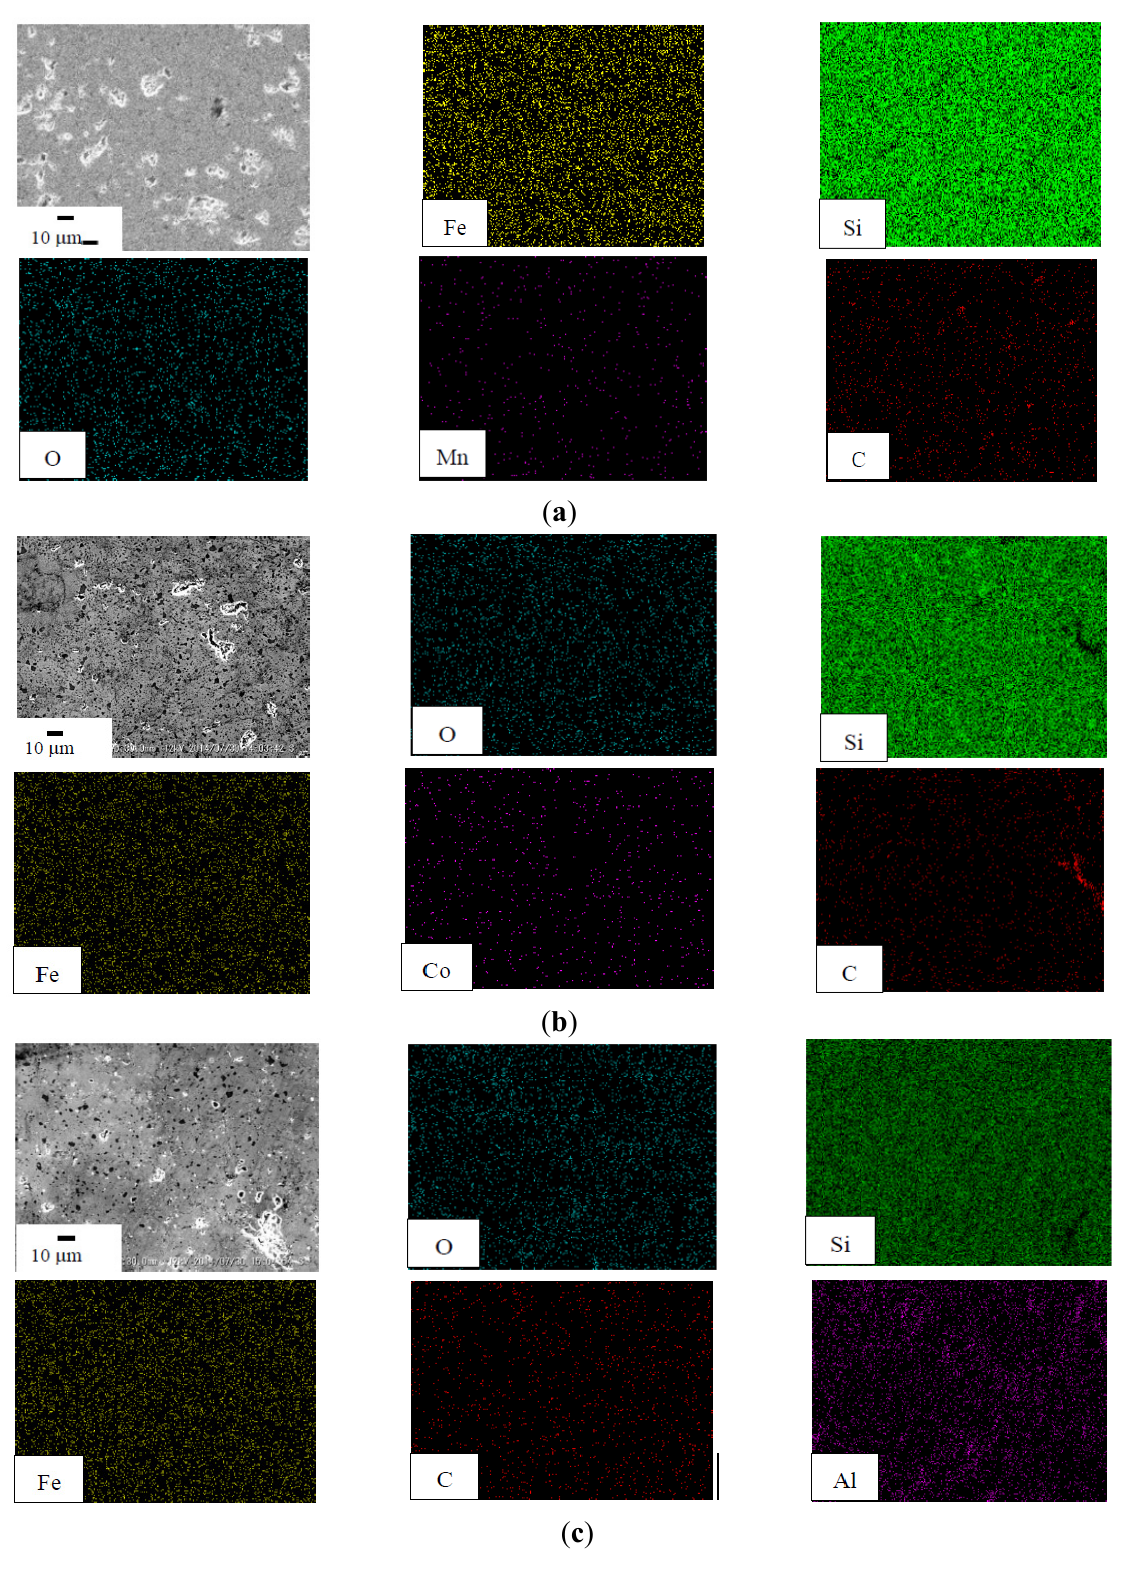
Figure 6. ( a ) SEM image and EDX result of the C-U (C.I.-1.86Si); ( b ) SEM image and EDX result of the C-Co (0.98C.I.-0.02Co-1.86Si); ( c ) SEM image and EDX result of the C-Al